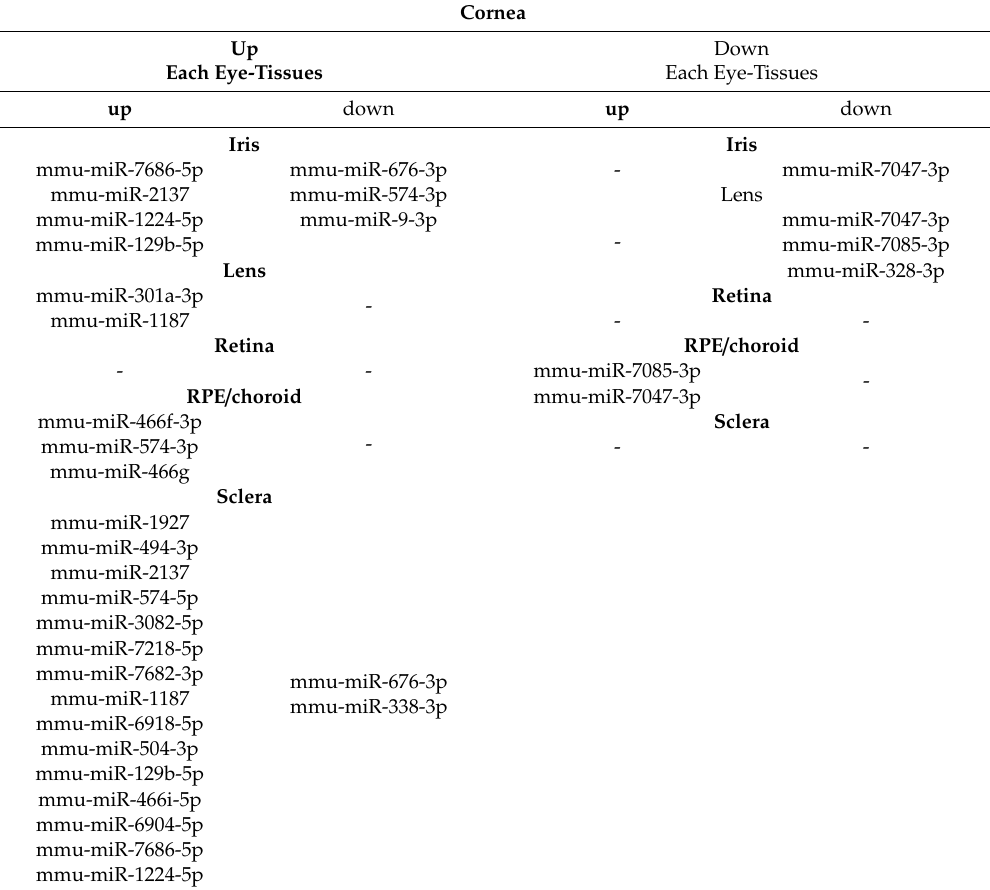
Table 2. Overlapping expression changes in miRNAs in corneal and other ocular tissues.